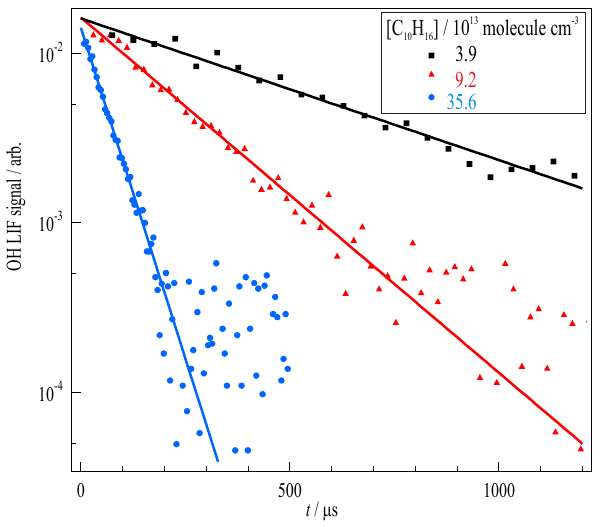
Figure 8. Plots of B parameters derived from Eq. (2) vs. associ- ated [ α -pinene] used to determine k 2 (OH + α -pinene) and k 3 (OH + (cid:49) -3-carene) in conditions of T = 296K and P = 97Torr (air). Weighted linear fits yield (in units of 10 − 11 cm 3 molecule − 1 s − 1 ) : k 2 (296K) = ( 5 . 3 ± 0 . 15 ) from the red squares and k 3 (296K) = ( 8 . 1 ± 0 . 1 ) (blue circles). Note that 2 σ statistical errors in B , used to weight these fits, were smaller than the symbols in this